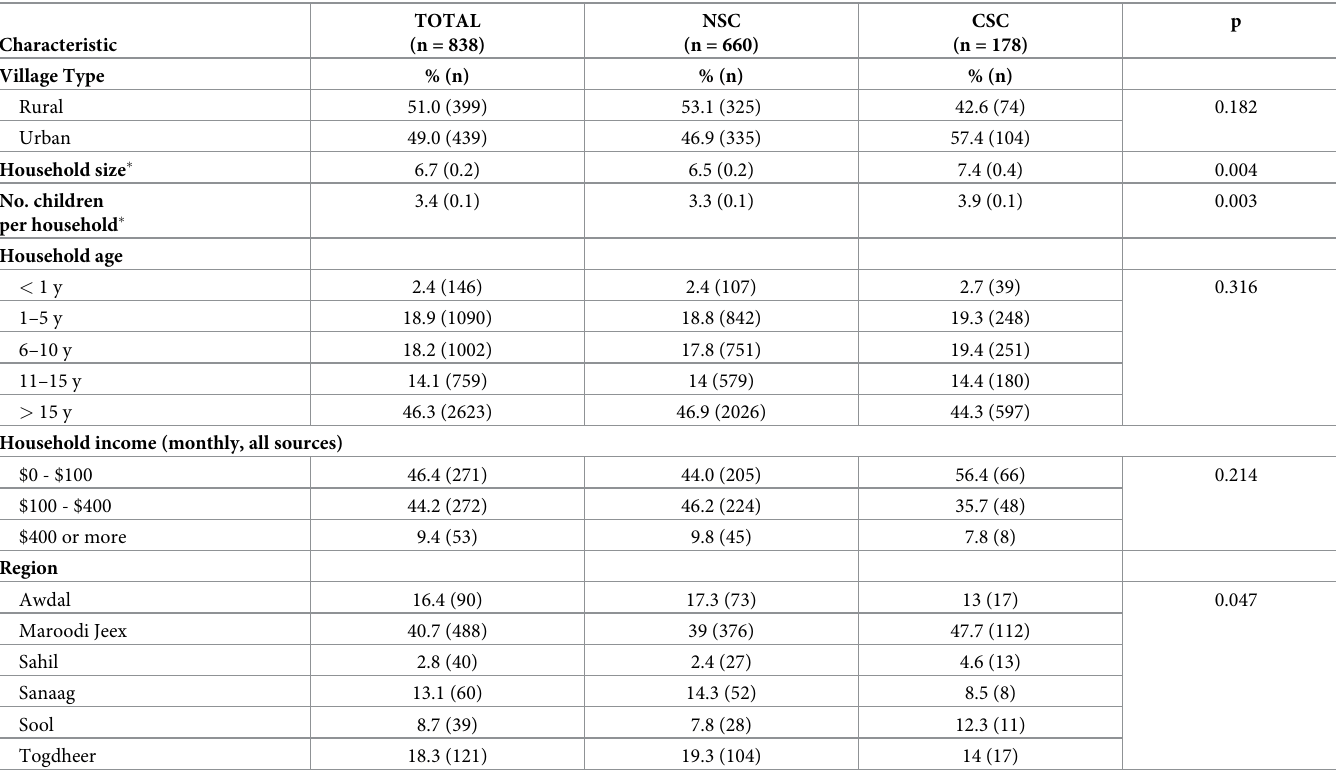
Table 3. Household demographics, stratified by households with a child with surgical conditions (N = 838). Characteristic